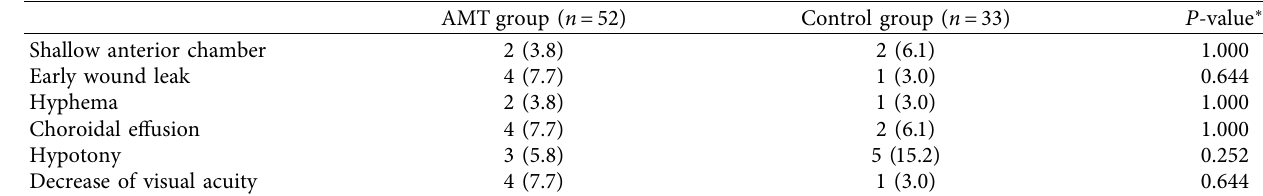
Table 3: Complication after trabeculectomy in both